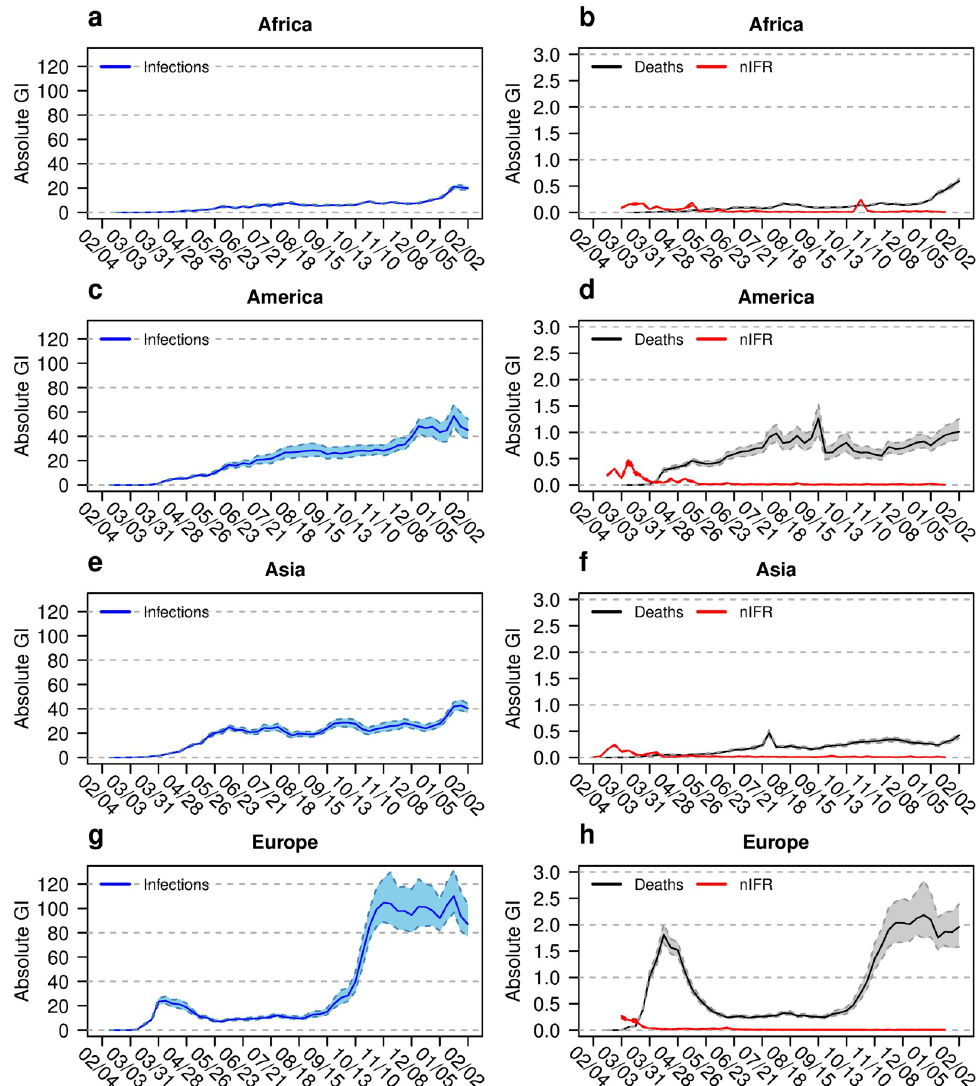
Fig 2. Absolute Gini indices for different continents. Absolute Gini indices (GI) for infection rates (left column), and for death rates and naive infection fatality rate nIFR (right column) for Africa (a and b), America (c and d), Asia (e and f) and Europe (g and h). The coloured bands show the 95% confidence intervals. The horizontal axis shows the time between February 2020 and February 2021.